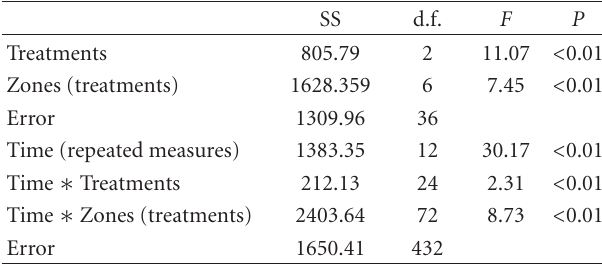
Table 3: Results of the nested repeated measures ANOVA test the e ff ect of treatments (burning, cutting, and ploughing) in S α , nesting zones (A, B, and C) into